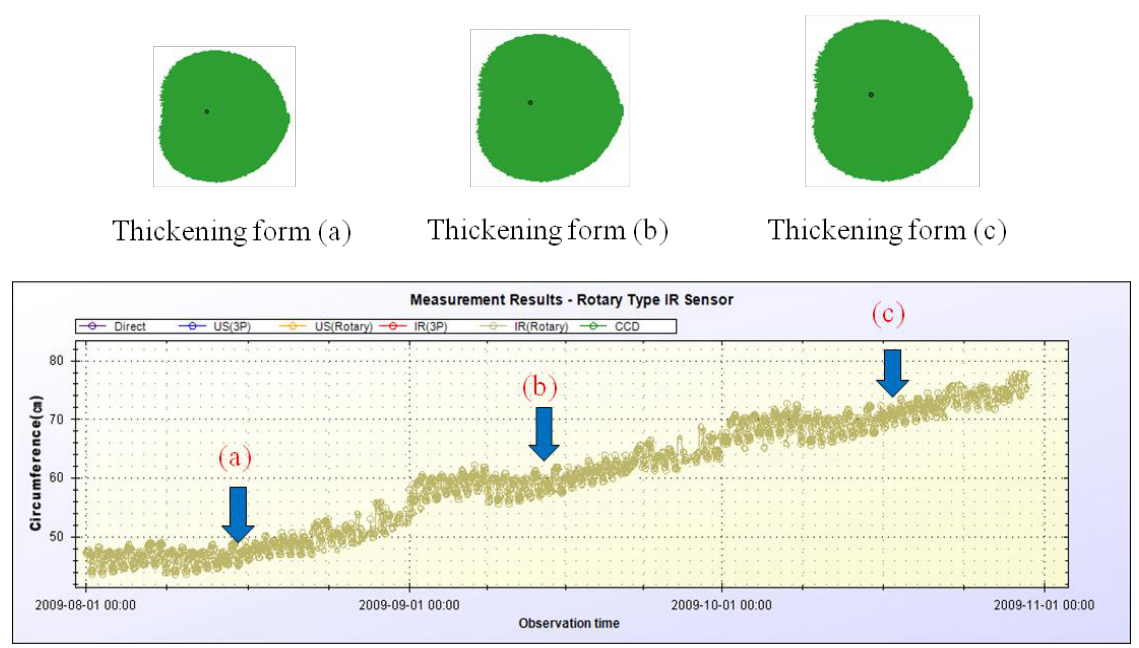
Figure 25. Measurement results obtained using the rotary-type measurement